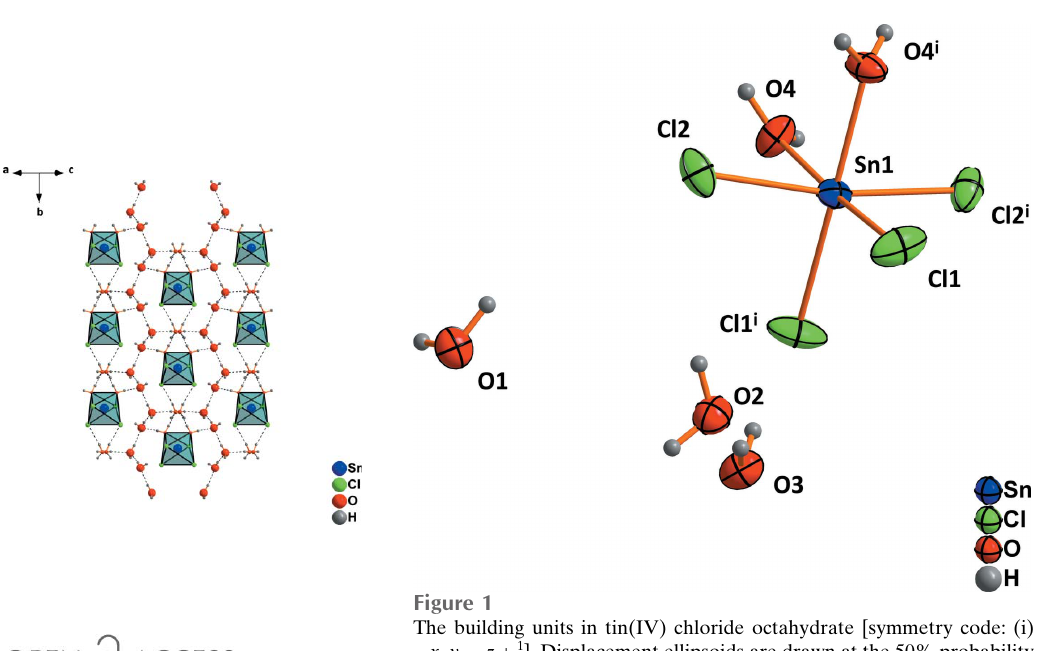
Figure 1 The building units in tin(IV) chloride octahydrate [symmetry code: (i) (cid:3) x , y , (cid:3) z + 1 ]. Displacement ellipsoids are drawn at the 50% probability 2